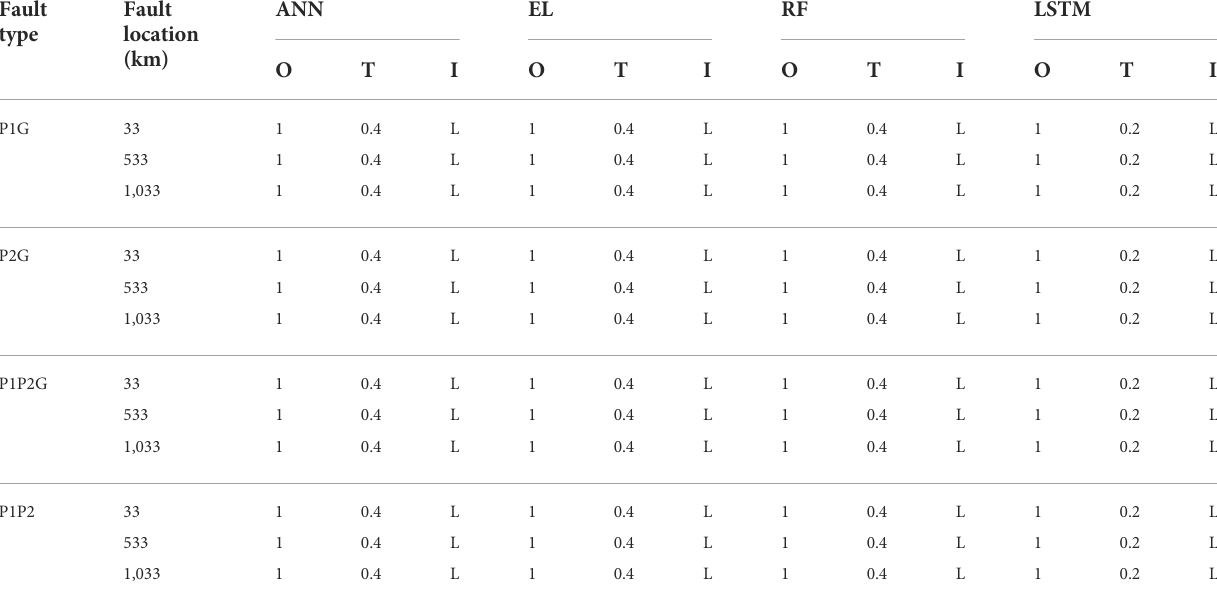
affected by fault resistance. In this work, the proposed method has been tested with various fault resistance up to 100 Ω .